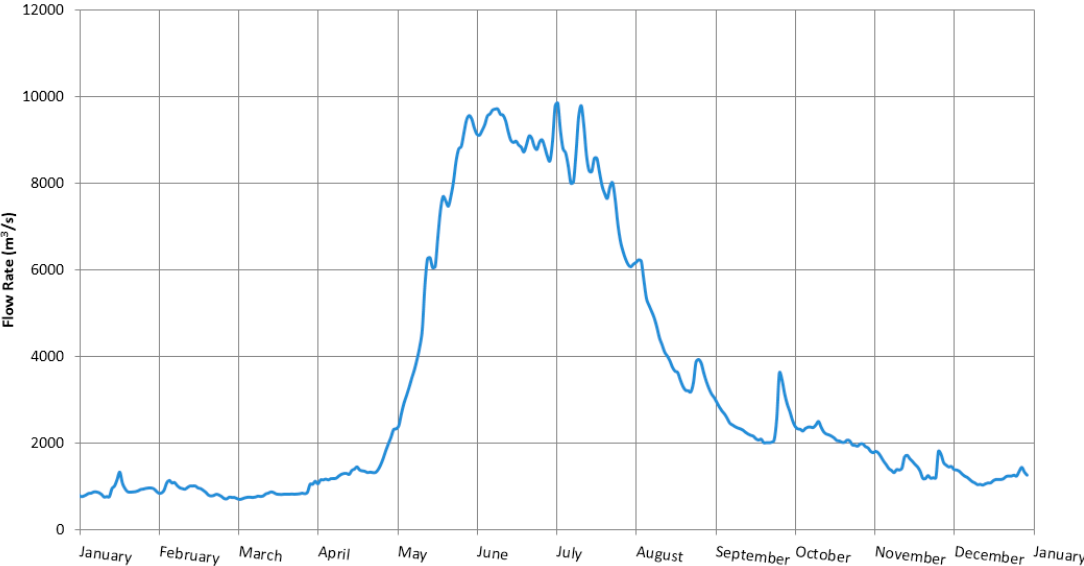
Figure 4. Fraser River flow rate at Hope in 2011.